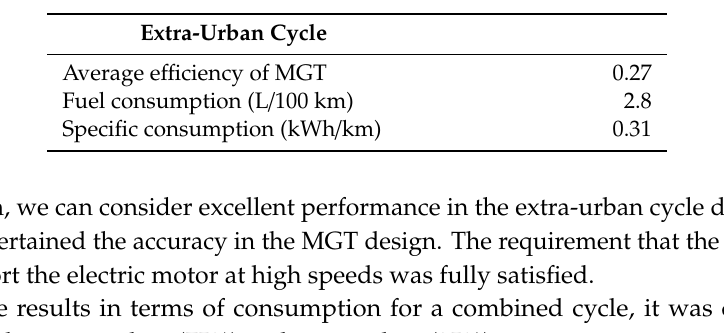
Table 18. Extra-urban cycle results.